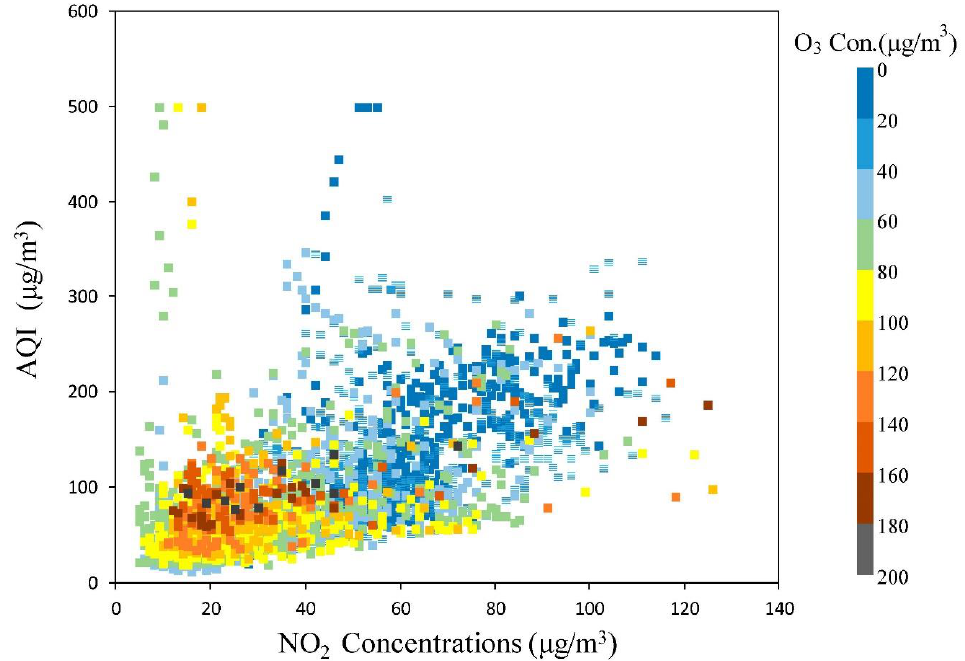
Figure 6. AQI and NO 2 concentrations scatter chart (Ozone concentration as color information) from